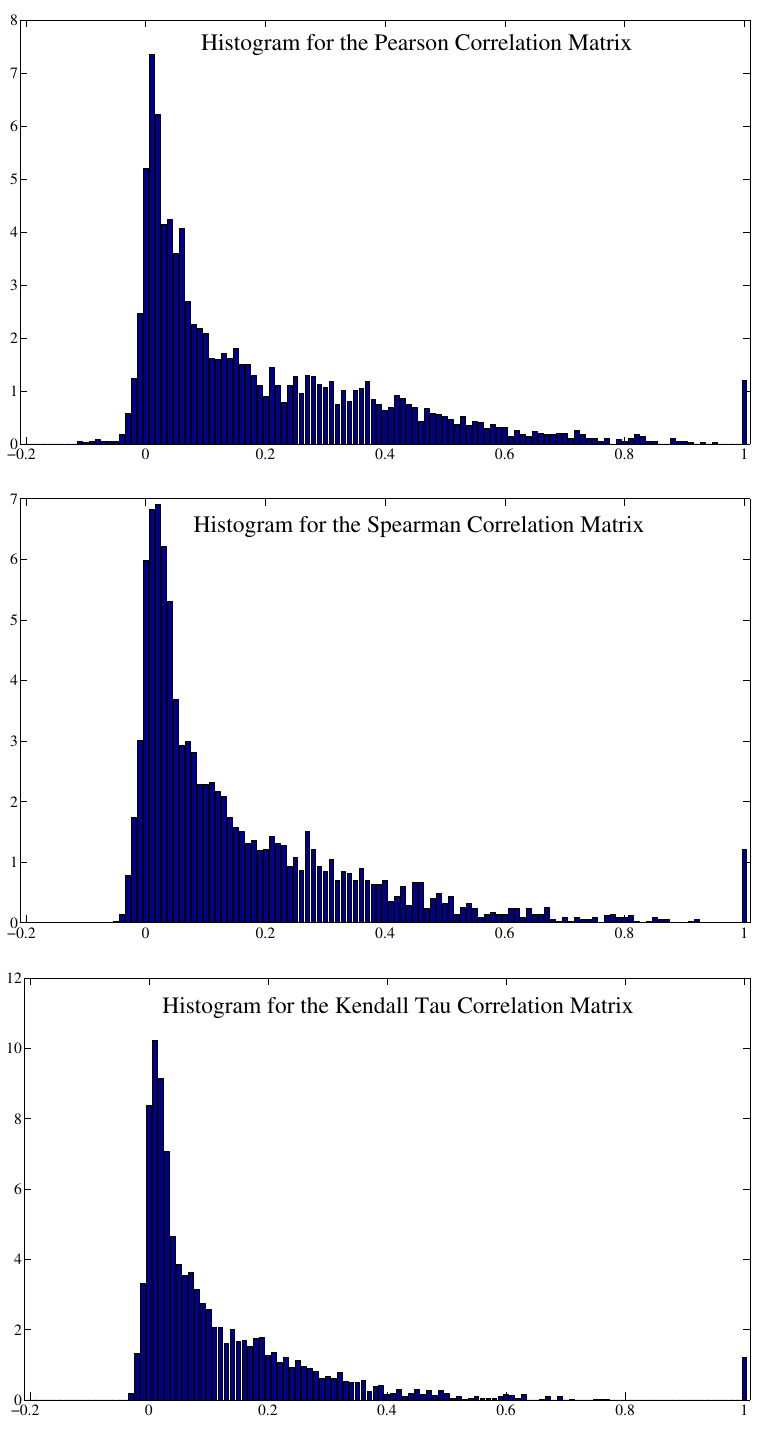
Figure 23. Histograms of the elements of the correlation matrices obtained from three different correlation measures: Pearson correlation, Spearman rank correlation, and Kendall tau rank correlation,